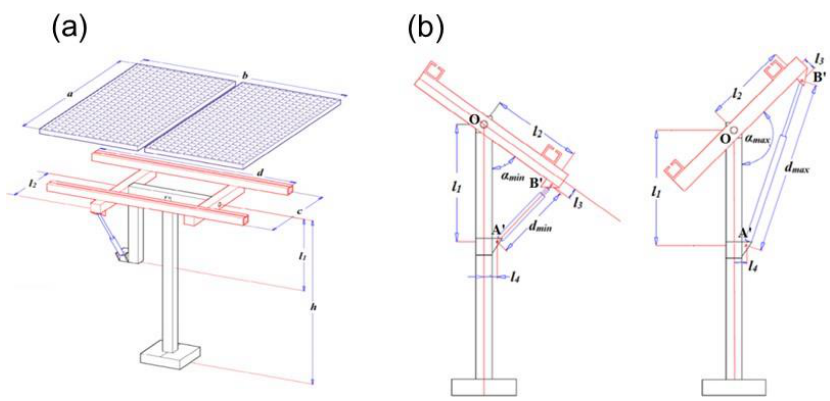
Figure 2. Mechanical model of the single-axis sun tracker. ( a ) General view; ( b ) view along the axis of rotation.